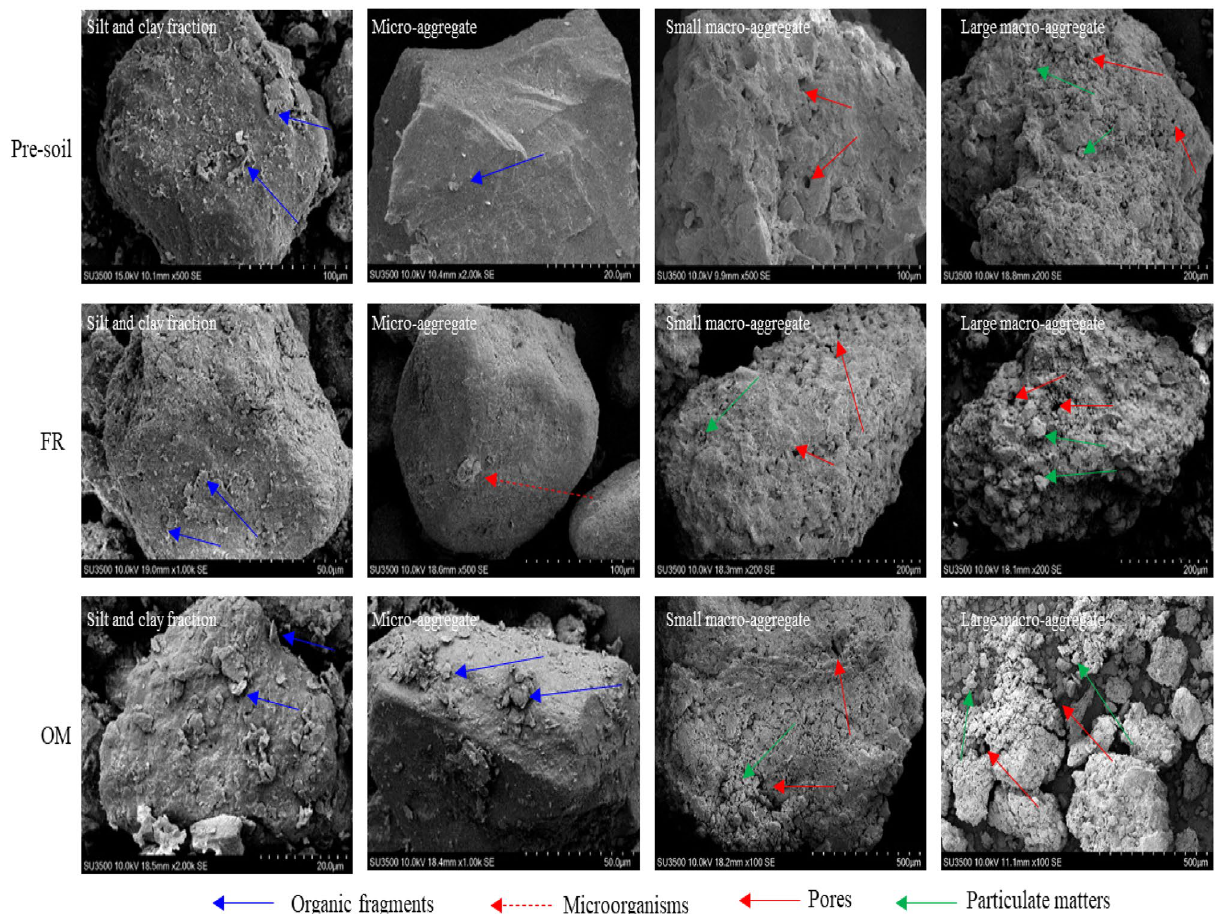
Figure 5. Scanning electron micrograph of water-able aggregates in different